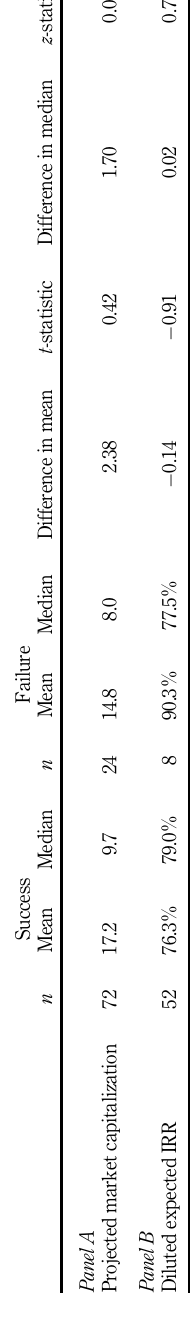
Table 8. Estimated equity market value and expected IRR divided by project success or